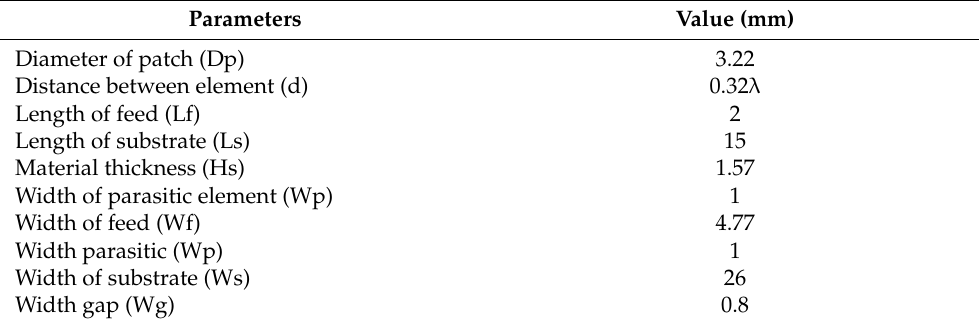
Figure 7. Proposed antenna with C-shaped parasitic structure. Table 2. Antenna parameter.